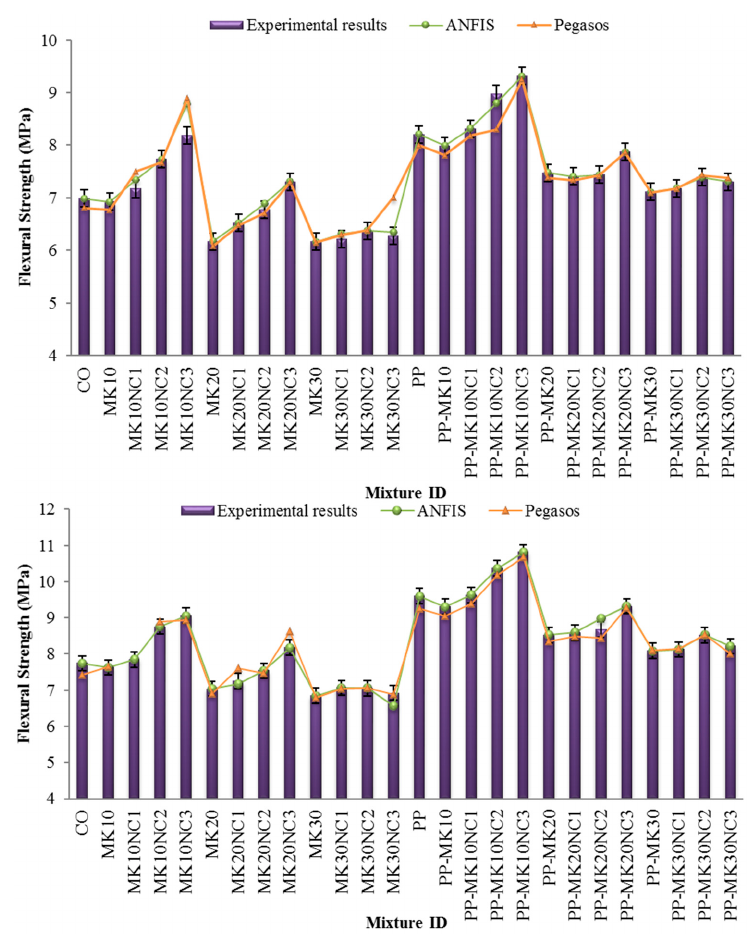
Figure 9. Flexural strength of mortars at: 28 days ( top ); and 90 days ( below ).